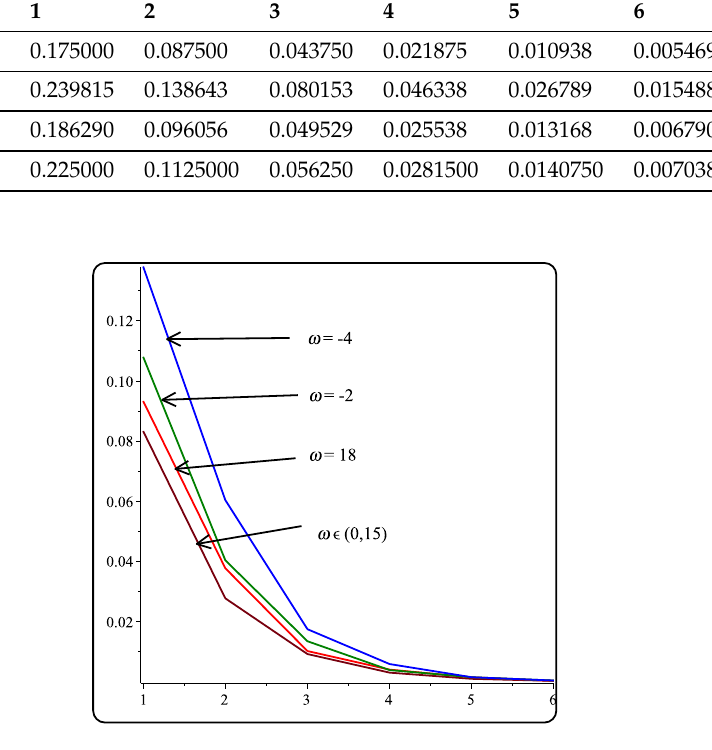
Figure 2. Error bounds of ternary scheme (Equation (12)).